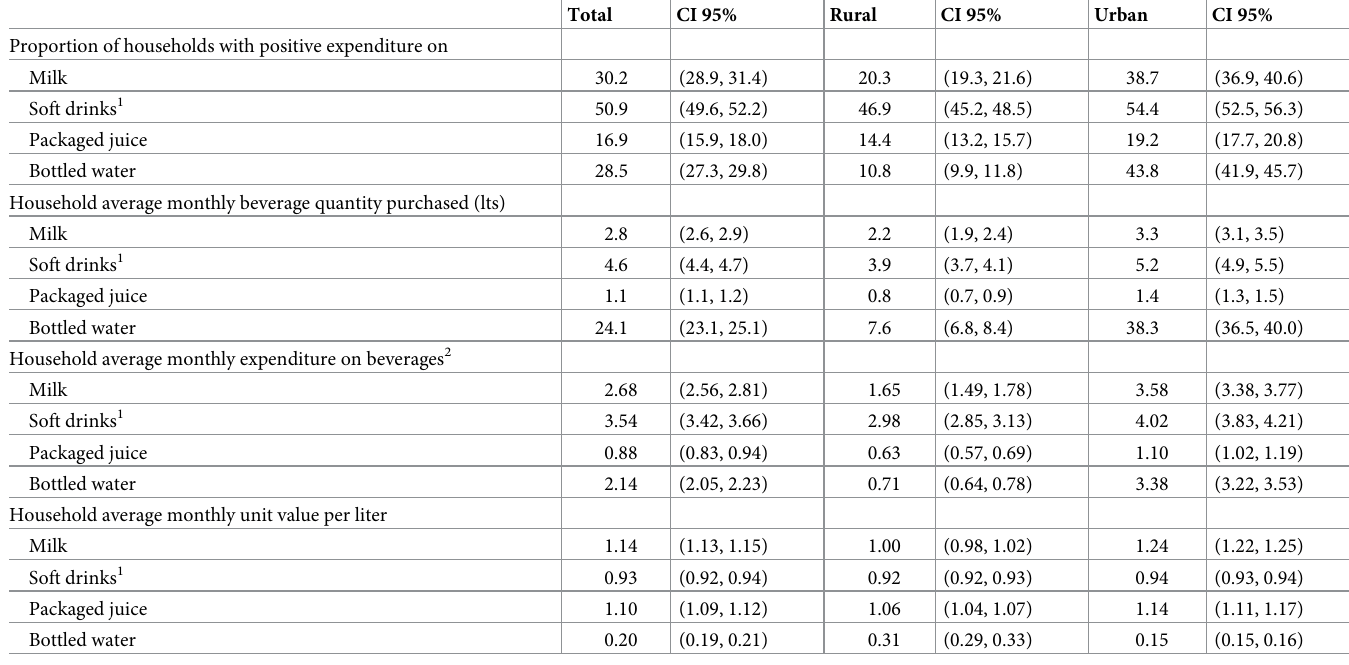
Table 2. Beverage consumption by area,